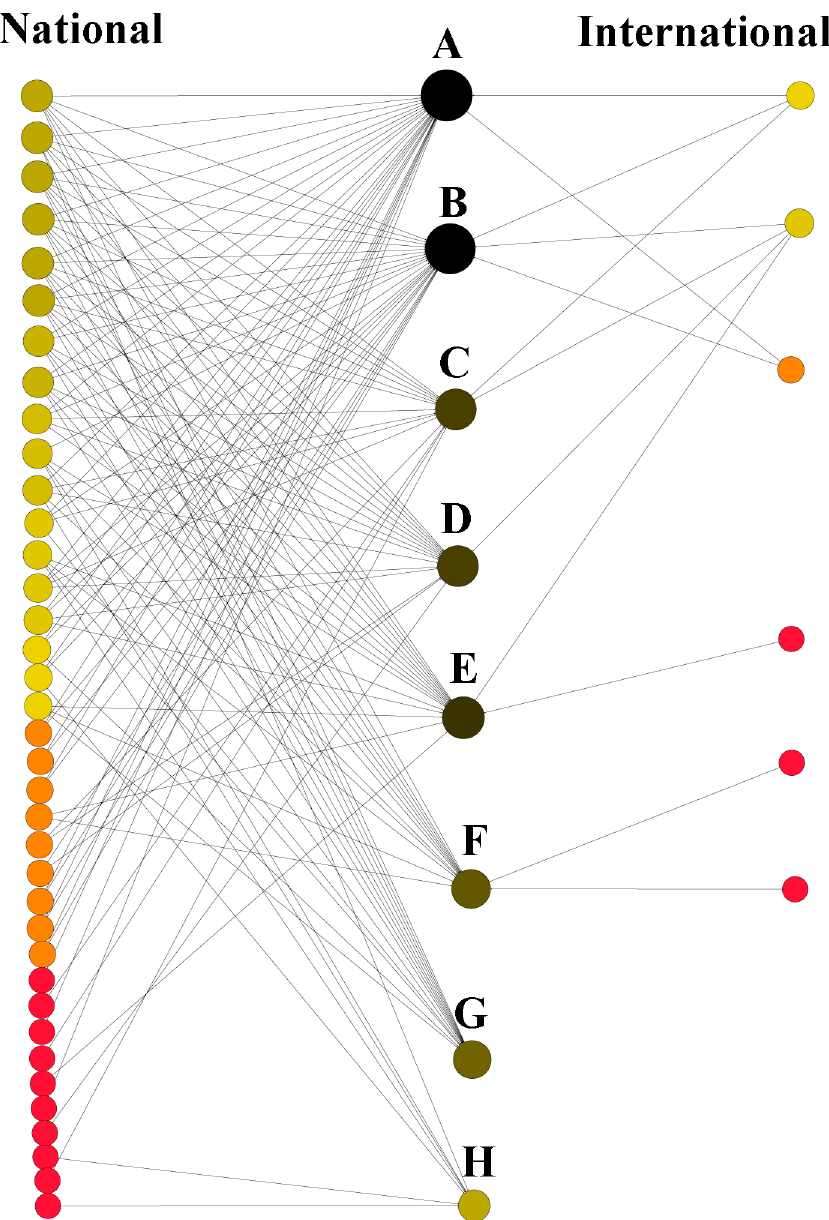
Fig 6. Contribution of each national and international research institute/university in the scientific collaboration network. Sizes and colors of the circles represent the contribution of each institute to the network. Aquatic species (A – H) are shown in descending order of number of studies in the Legal Brazilian Amazon. A, Podocnemis unifilis ; B, Podocnemis expansa ; C, Caiman crocodilus ; D, Melanosuchus niger ; E, Inia geoffrensis ; F, Trichechus inunguis ; G, Sotalia fluviatilis ; H, Trichechus manatus